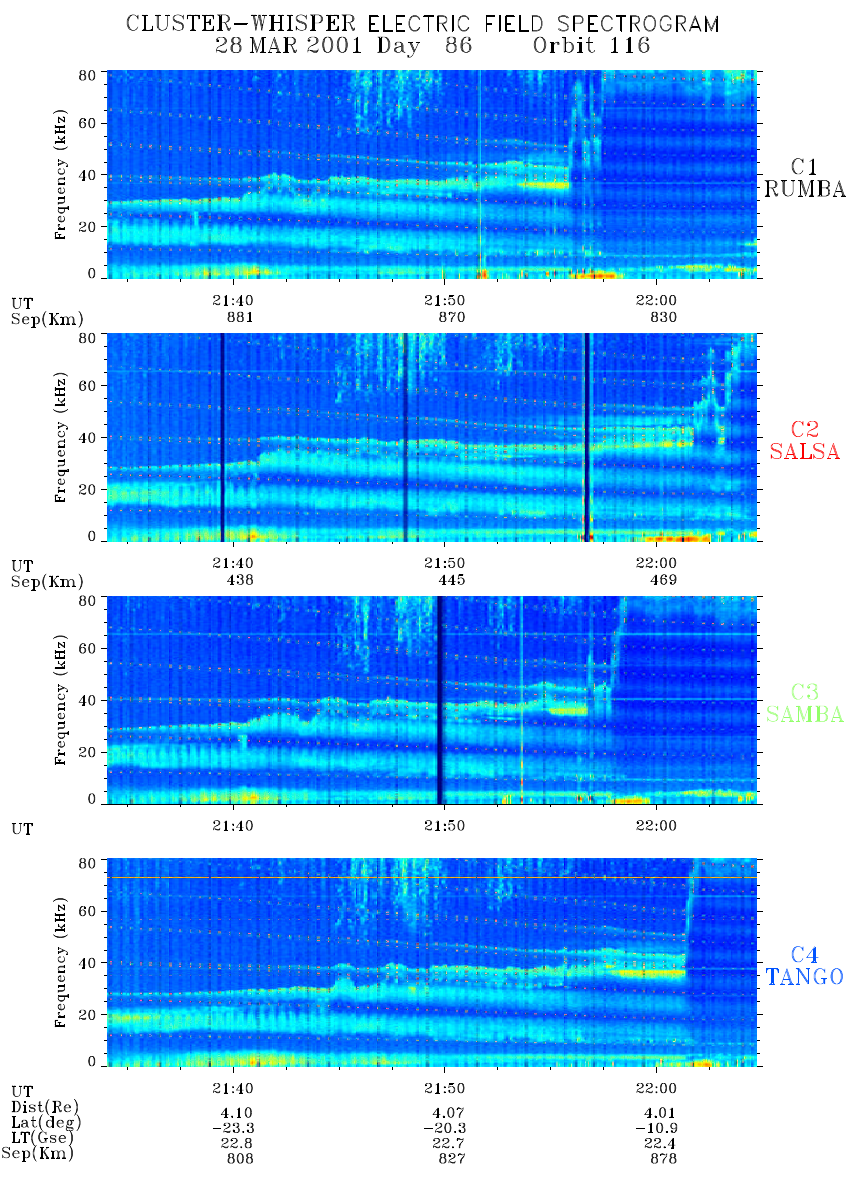
Fig. 10. Dynamic spectrograms ob- tained from the four spacecraft as they encounter the plasmapause on 28 March. Electric field signal strength ranges from about 5 · 10 − 6 (blue) to 5 · 10 − 4 V/Hz − 1 / 2 (red). Broad band spin modulated emissions are ob- served below Fp , which itself is a faint, barely visible emission seen rising on Salsa, from about 25kHz at 21:40UT to about 35kHz at 21:45UT and 40kHz at 22:00UT. Narrow band Fqs are seen above Fp . The small dots are the res- onances triggered by the sounder. The horizontal red bar at 72kHz on Tango is an